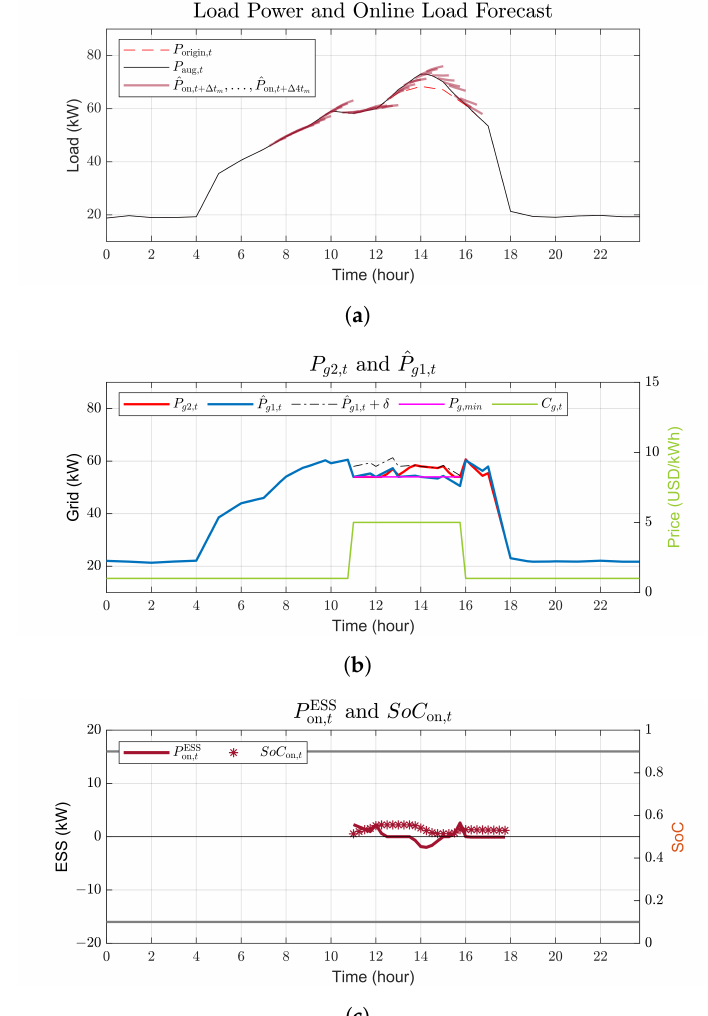
Figure 15. Online ESS operation at δ = 4. ( a ) Online load forecast, ( b ) The estimated power ˆ P g 1, t and real power P g 2, t from the main grid by using both ESS off and ESS on , ( c ) The amount of charging or discharging of ESS on and SoC on, t